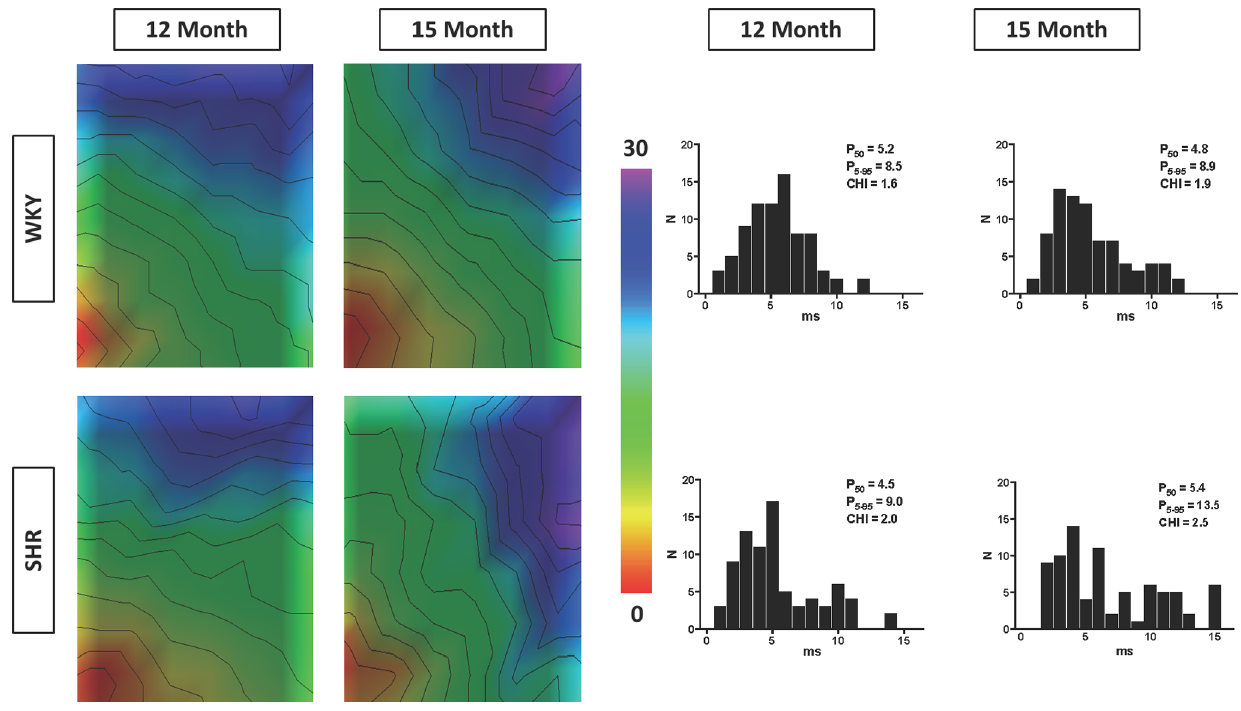
Figure 2. Representative Atrial Activation Maps. Activation maps from representative left atrium of both WKY (top row) and SHR (bottom row) during pacing with S1 at 200 ms are shown here. Isochronal lines of 2 ms are superimposed with fixed time range from 0 to 30 ms. Overall plaque activation times are similar indicating comparable atrial conduction velocity. However, the SHR demonstrated higher conduction heterogeneity as compared to the WKY, which were further increased with ageing. Corresponding phase histograms of these activation maps are also shown on the right panel of this figure.